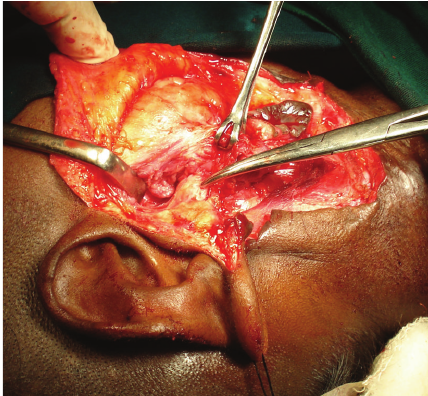
Figure 5: Perioperative photographs showing the thickened aural end of the fistula shown by tip of an artery forceps.